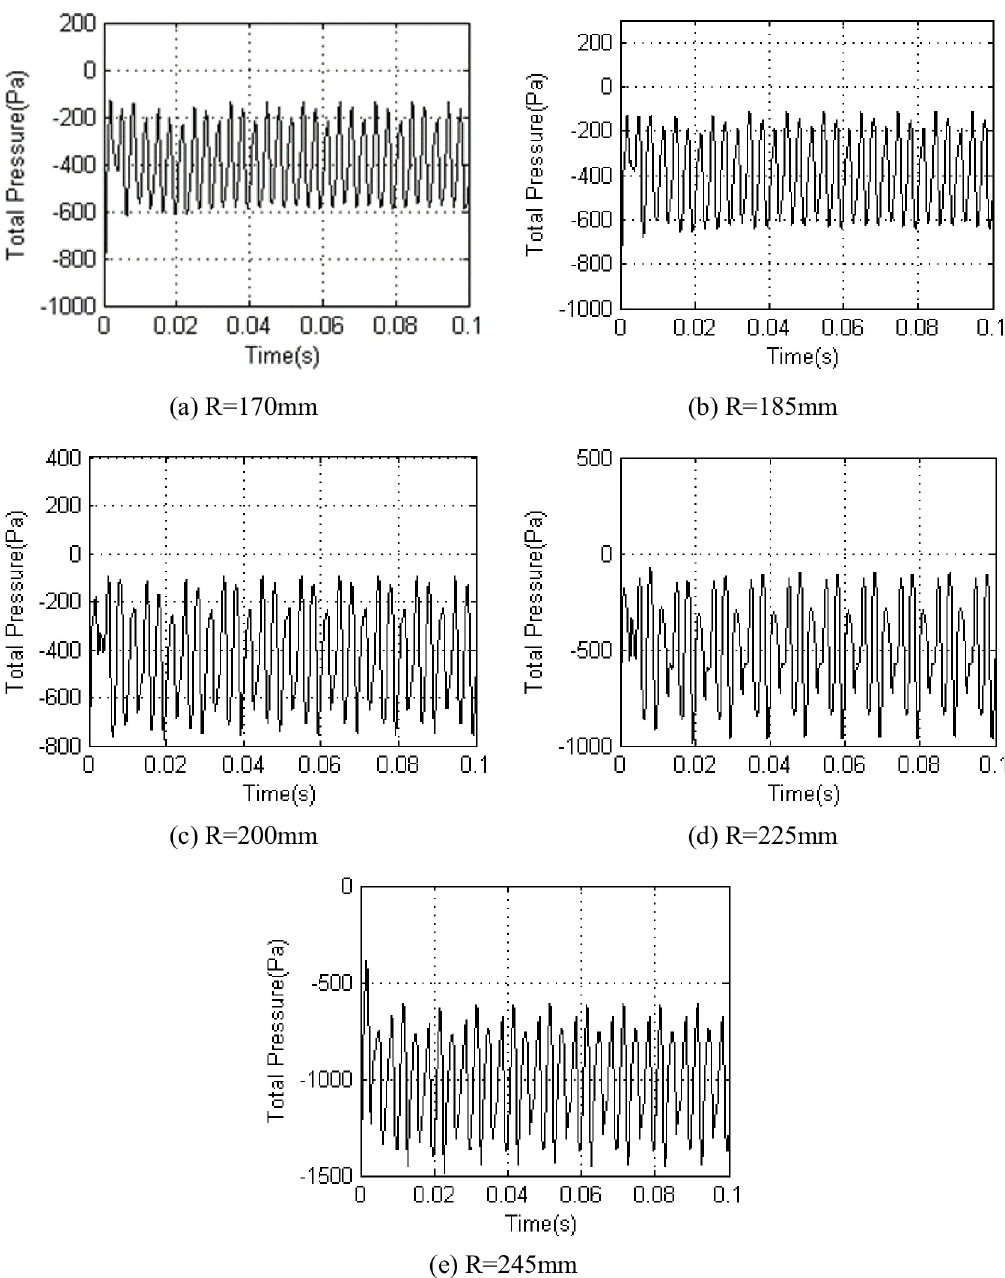
Fig 3. Interstage pressure pulsation on different radius under F =